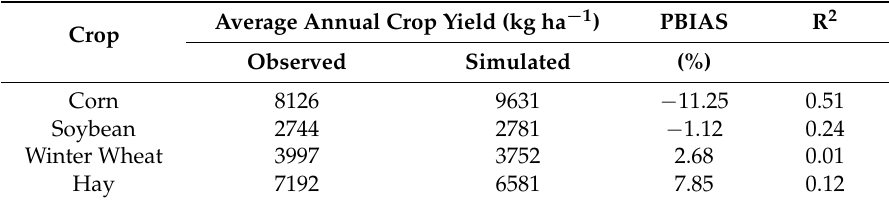
Figure 7. Comparison of SWAT simulated and reported ( A ) corn and soybean and ( B ) winter wheat and hay yields in Hancock County, Ohio for the simulation period. Table 7. Annual summary statistics from 2005 to 2014 for crop yield calibration for the Eagle Creek watershed, Ohio SWAT model.